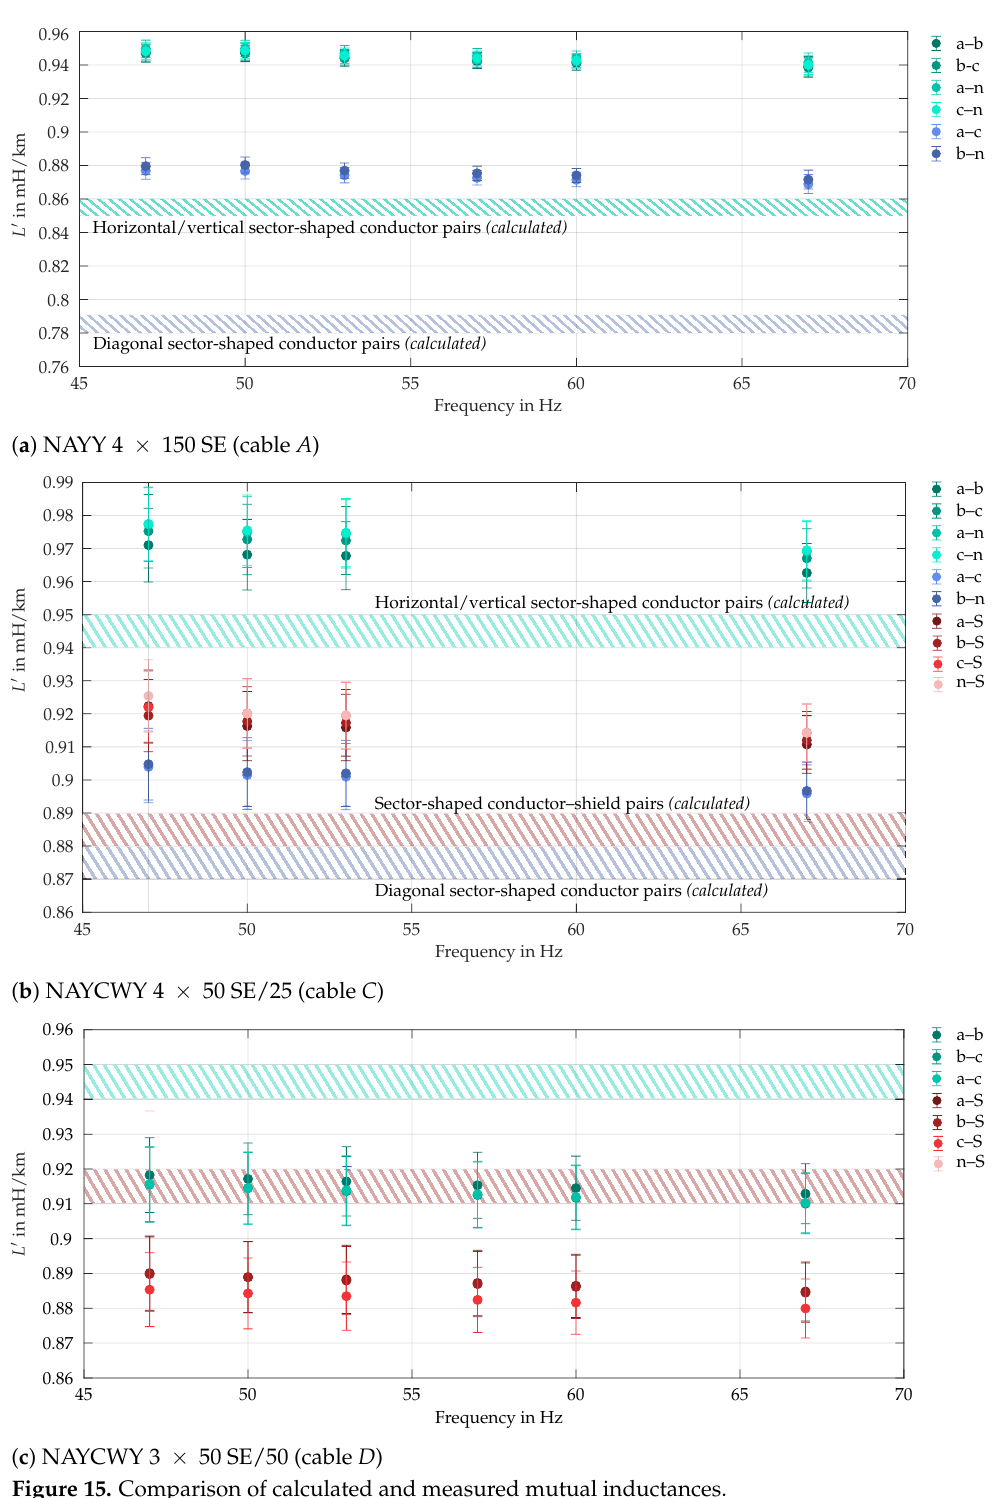
Figure 15. Comparison of calculated and measured mutual